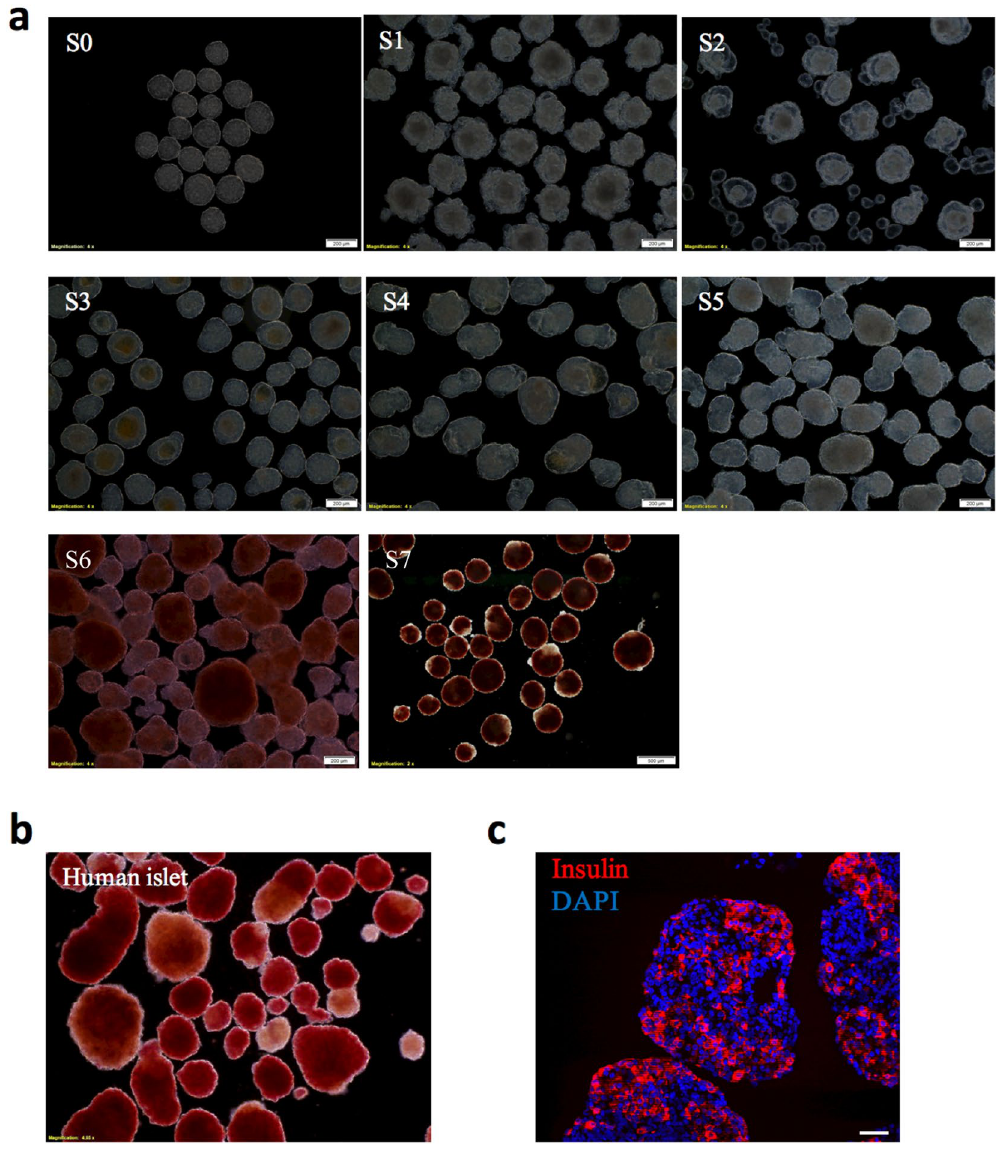
Figure 3. Human islets and insulin-producing cells differentiated from embryonic stem cells are rapidly identified by iDTZ. Stage 6 and 7 cell clusters were stained positively by iDTZ as compared to other stages (1–5) ( a ). Human islets stained with iDTZ ( b ). Immuno-fluorescent staining of stage 7 differentiated human embryonic stem cells showing insulin (red), and DAPI staining of the nucleus (blue), ( c ). The scale bar represents 50 μ